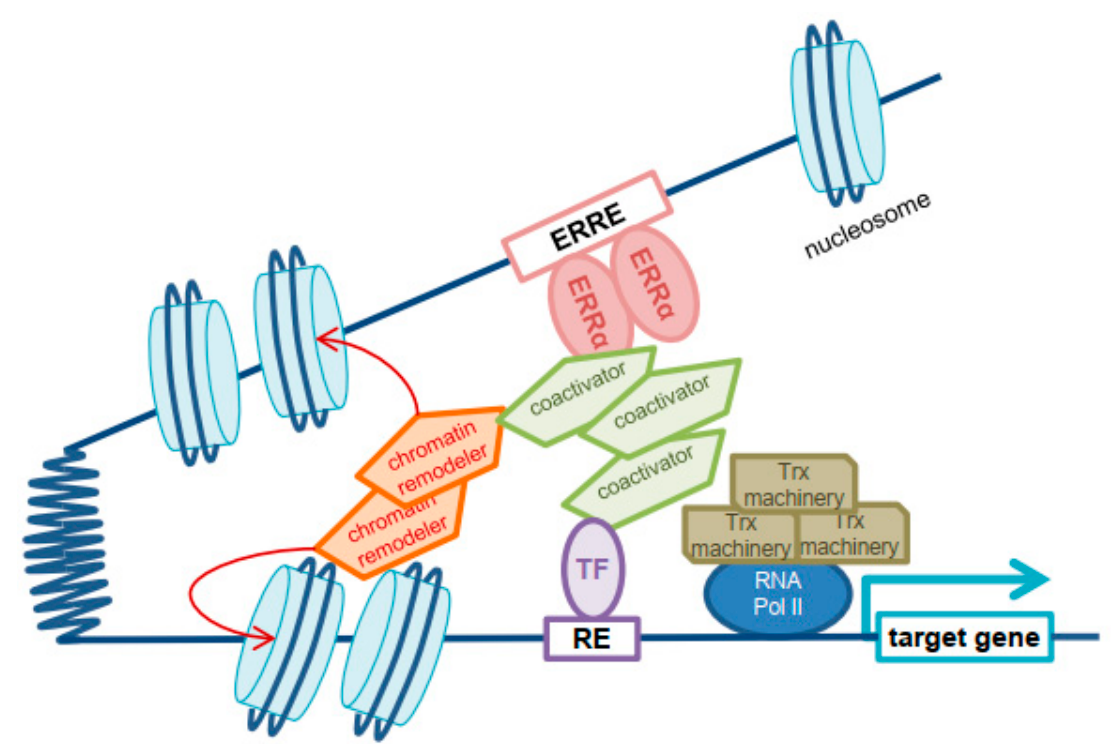
Figure 1. Schematic model of transcriptional regulation operated by ERR α and its coactivators. The estrogen-related response element (ERRE) is often located at a distance from the target gene promoter. Chromatin remodelers allow access of ERR α to nucleosomal DNA. TF: transcription factor; RE: response element; Trx: transcription.